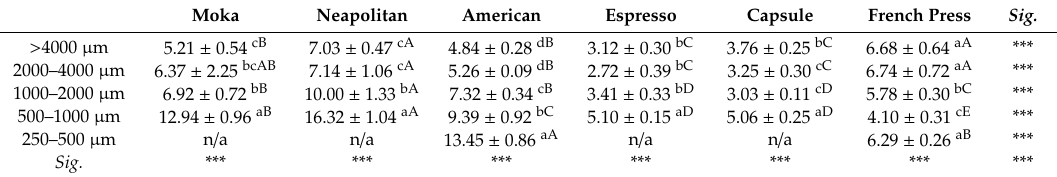
Table 5. Total phenolic content for the beverages after normalization considering CBS and water quantities. ANOVA among GDs and extraction techniques. Values are expressed in milligrams of gallic acid equivalents for each gram of CBS powder employed for the beverage preparation (mg GAE / g CBS). Moka Neapolitan